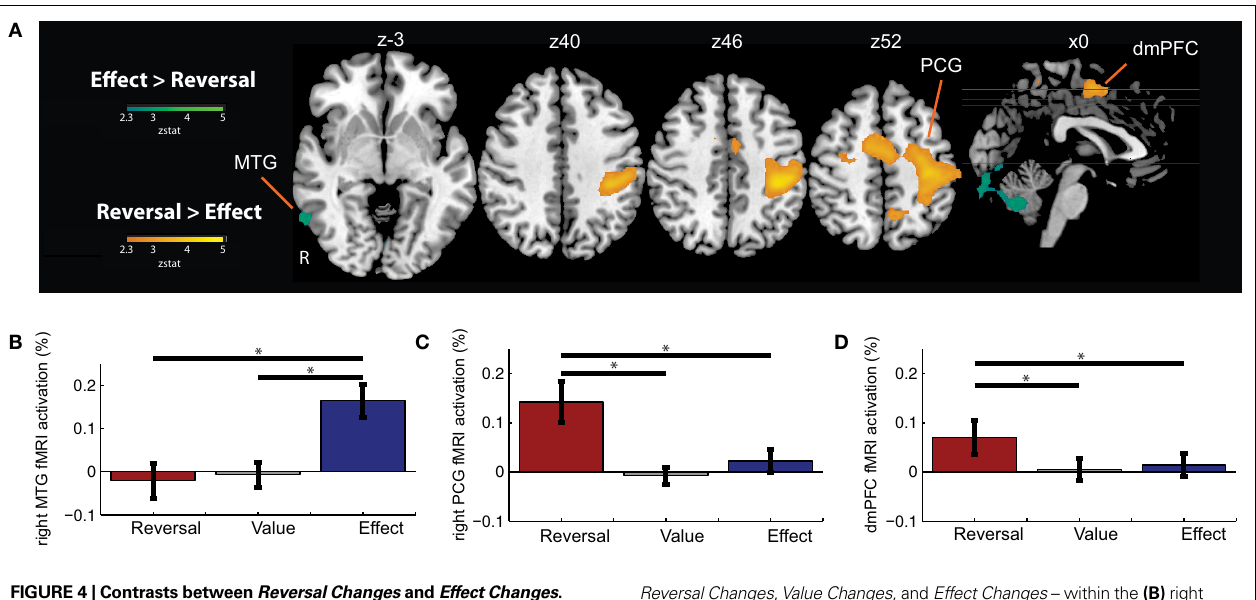
Reversal Changes , Value Changes , and Effect Changes – within the (B) right middle temporal gyrus (MTG), (C) right precentral gyrus (PCG), and (D) dorsomedial prefrontal cortex (DMPFC). Horizontal lines indicate pairs of conditions with signifi cant differences in activation amplitude ( p < 0.05).